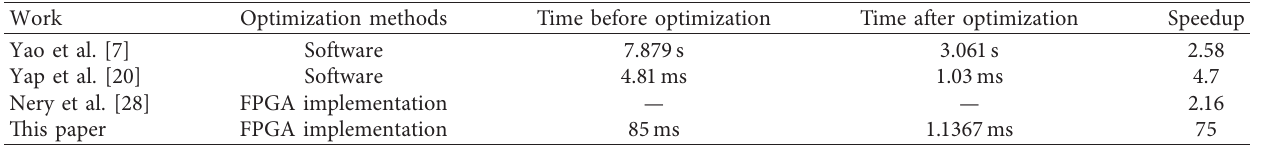
Table 6: Comparison results with related